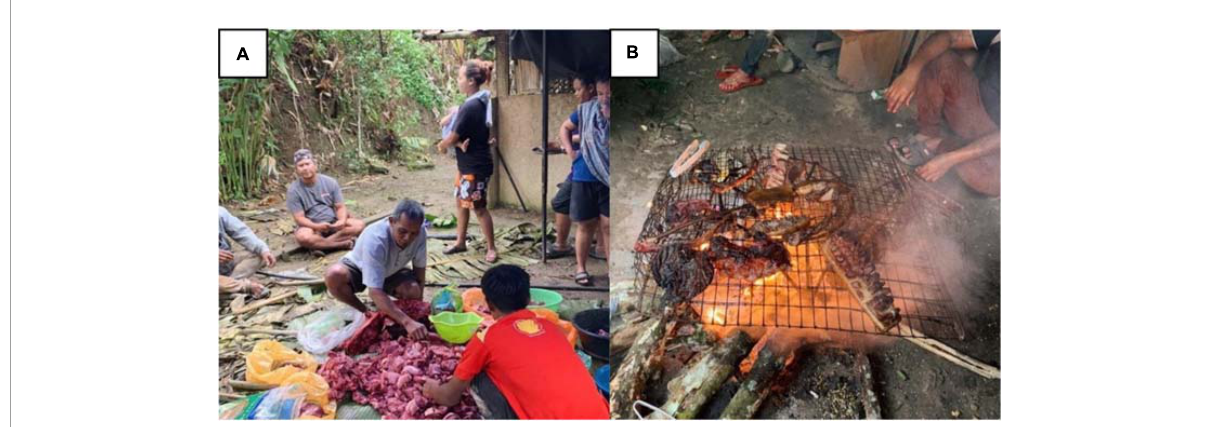
FIGURE6 Butchered wild boar meat to be distributed to the community (A) as they gather to have barbecue (B) . Source: Photographed by the first author in Hulu Langat, Selangor, Malaysia on 24 and 27 November